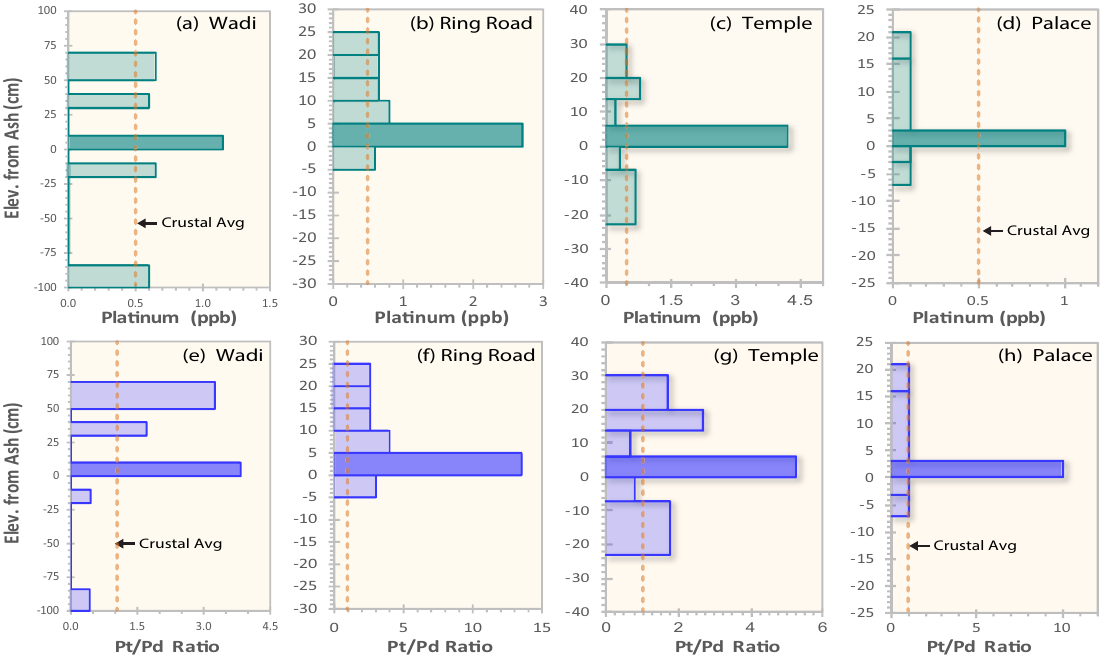
Figure 37. Plots for sedimentary Platinum and Palladium. ( a )–( d ) Platinum (Pt) concentrations. ( e )–( h ) Platinum/palladium ratios (Pt/Pd). Depths are in cm above or below the bottom of the destruction layer. Sample locations are labeled. Crustal abundance values (orange dashed lines) are ~ 0.5 ppb for